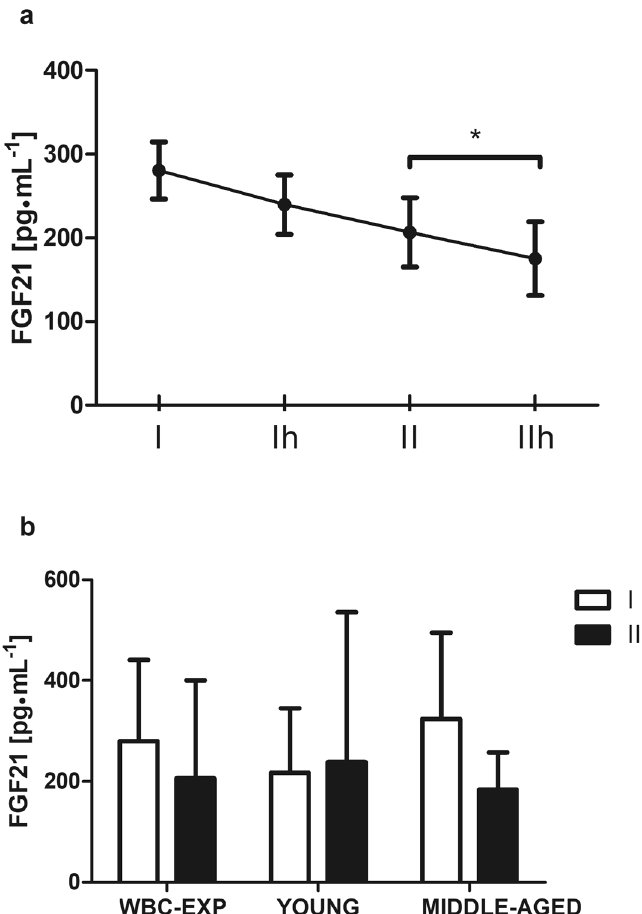
Figure 3. Changes in the concentration of FGF21 (data are presented as mean ± SEM) recorded: ( a ) at each point of blood collection: (I) before WBC, (Ih) 1 h after the first WBC, (II) before the last WBC and (IIh) 1 h after the last WBC; ( b ) in the WBC-EXP group with age-dependent changes before the first (I) and the last (II) session of WBC. * p < 0.05 significant differences between time point